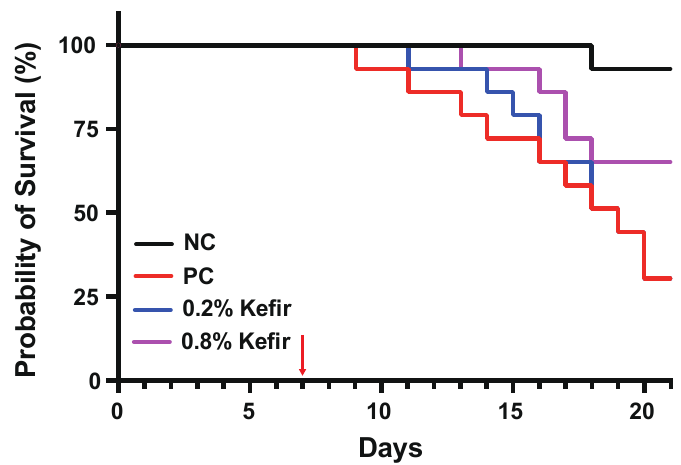
Figure 3. Survival rate of L. vannamei against WSSV infection according to treatment of kefir. NC and PC indicate negative and positive control group, respectively. Red arrow indicates the day when WSSV filtrate was injected except for the negative control group.